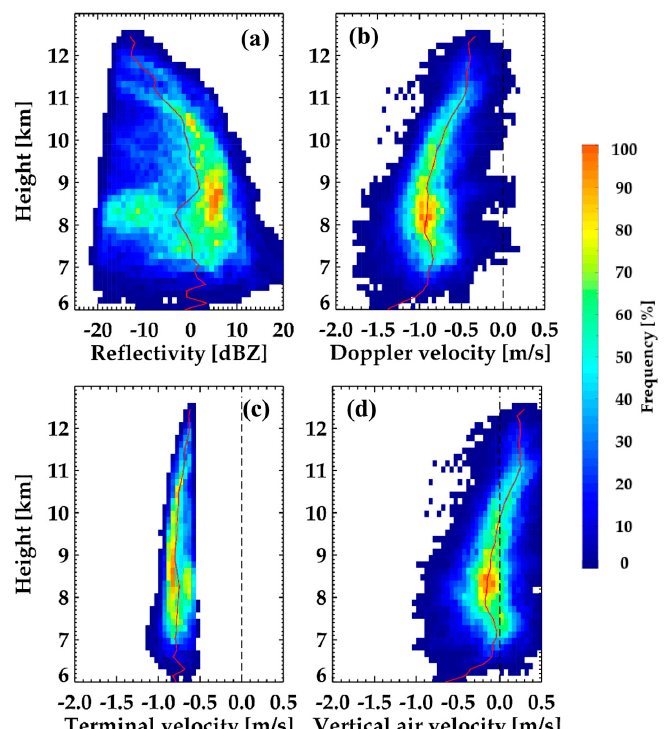
Figure 15. CFADs of ( a ) reflectivity, ( b ) Doppler velocity, ( c ) terminal velocity, and ( d ) vertical air velocity for a HC case on 9 August, 2015. The median is shown in the red line.